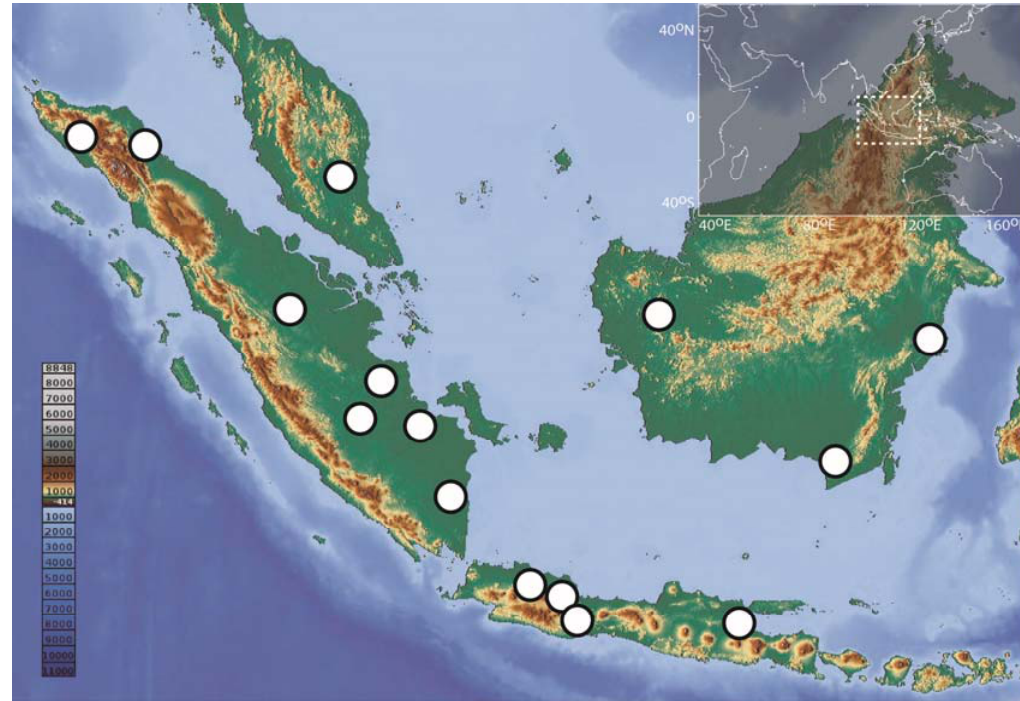
Figure 1. Collecting sites in Sundaland for the 173 DNA barcode records of Barbonymus analyzed in this study.